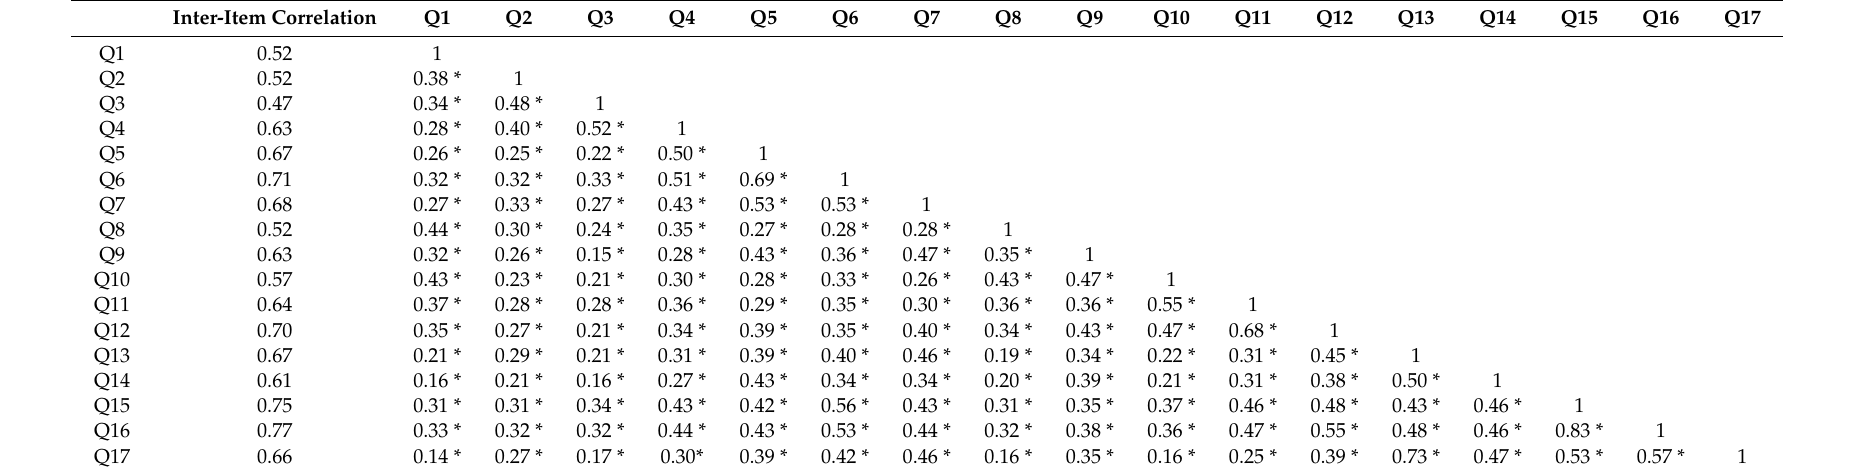
Table 2. Inter-item correlations 4CornerSAT questionnaire to measure the career satisfaction of physicians in